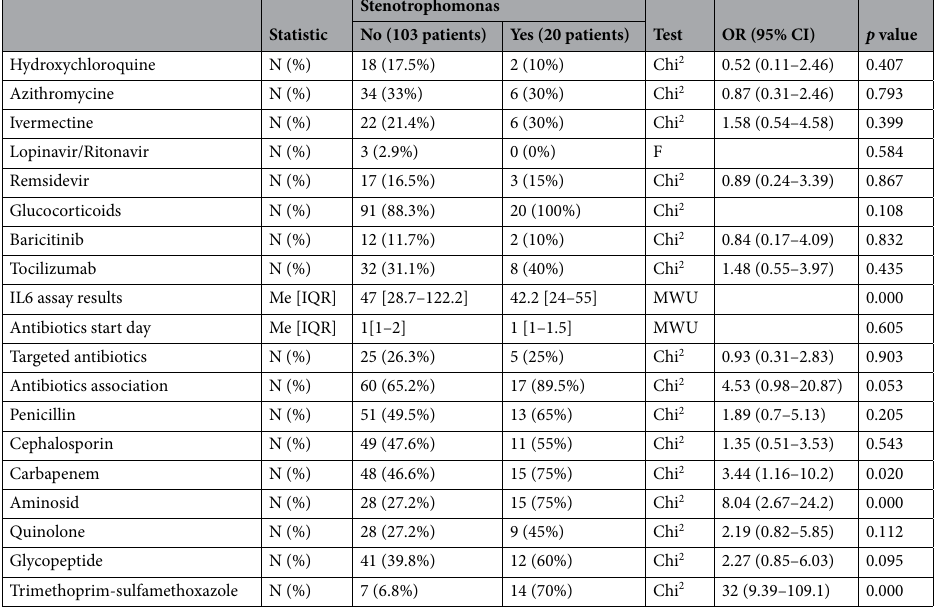
Table 3. Treatment characteristics in the 2 groups without and with Stenotrophomonas infection. Categorical data are presented as frequencies and percentages (N (%)); Continuous data departing from normality assumptions and ordinal data are presented as Median with its interquartile range (1st quartile–3rd quartile) (Me [IQR]). Chi 2 : Chi square test; MWU: Mann–Whitney U test. For binary data, the odds ratio with its 95% confidence interval were calculated [OR (95% CI)]. F: Fisher exact test. T: independent samples T test.